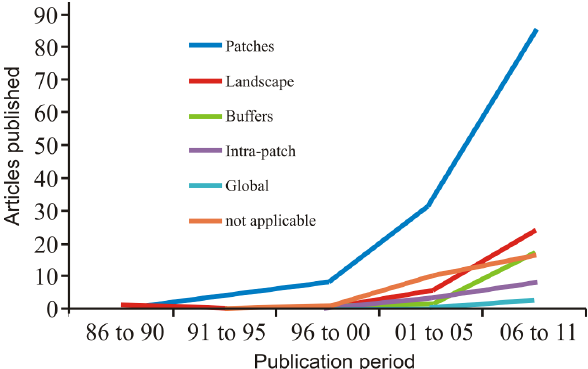
F IGURE 5. Temporal changes (number of studies/period) of the approach Level of the study (N= 219).